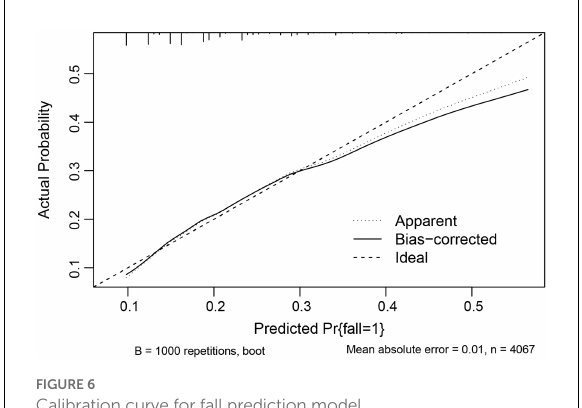
FIGURE 6 Calibration curve for fall prediction